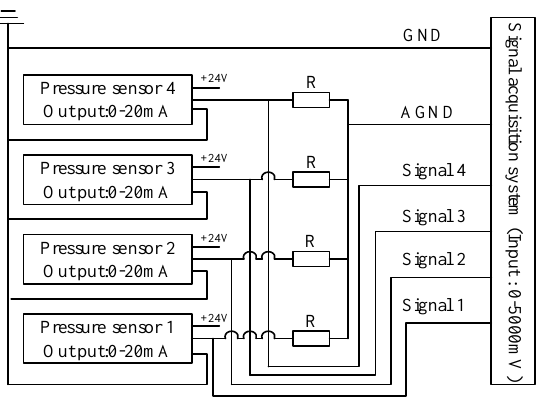
Figure 14. The principle of data transmission and acquisition.